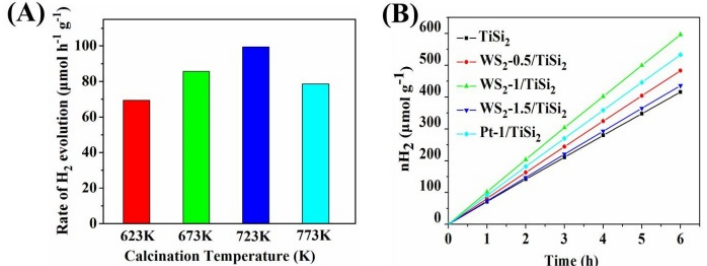
( B ) the hydrogen production of TiSi 2 , WS 2 - x /TiSi 2 -723, and Pt-1/TiSi 2 catalysts over 6 h. Reaction conditions: 50 mg catalysts, 60 mL 0.005 M oxalic acid aqueous solution, irradiation source: a 150 W Xe lamp equipped with a cut-off filter at 420